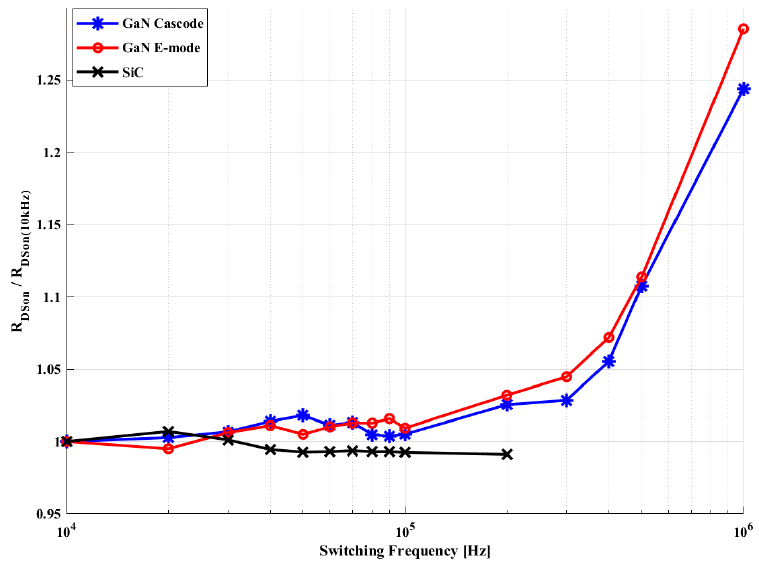
Figure 14. R DS,on /R DS,on (10 kHz) vs. switching frequency.